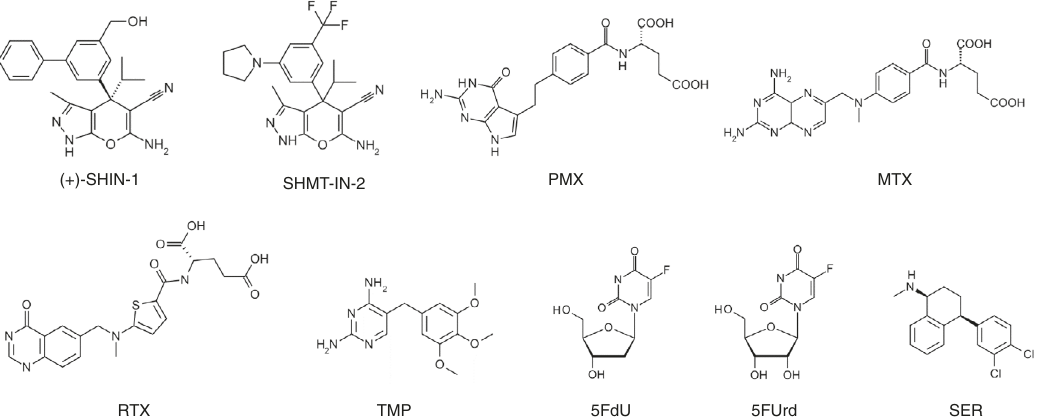
Fig. 1 Chemical structures of 1C metabolism-related compounds. Chemical structures are shown. SHMT-IN-2; SHMT inhibitor 2, PMX pemetrexed, MTX methotrexate, RTX raltitrexed, TMP trimethoprim, 5-FdU 5- fl uoro-2 ′ -deoxyuridine, 5-FUrd 5- fl uorouridine, and SER